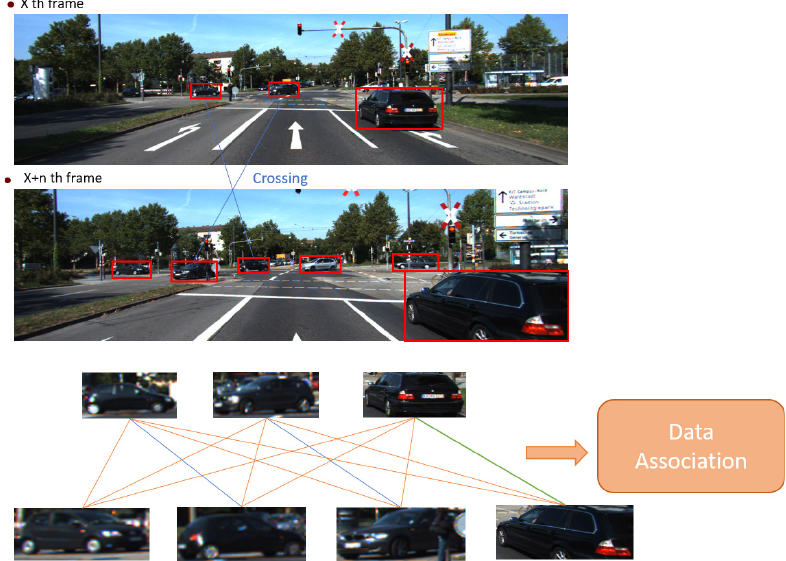
Figure 4. Structure of the data association stage. The red boxes represent the result detected from the object